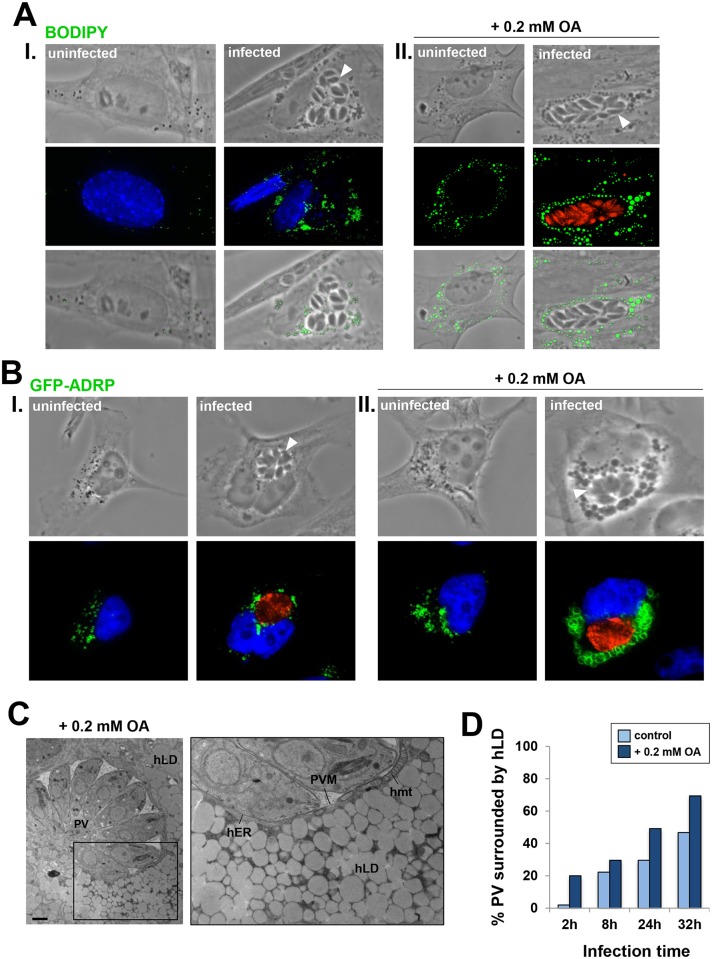
Influence of Toxoplasma infection on host LD distribution.A. Fluorescence microscopy of HFF infected with RFP-expressing Toxoplasma or WT for 24 h. Host LD were identified by staining with BODIPY 493/503 (green) and 4-,6-diamidino-2-phenylindole (DAPI, blue, nucleus). Uninfected and infected cells were incubated either under control conditions (corresponding to culture medium supplemented with 10% FBS that contains on average 3 μg/ml OA; in I) or with 0.2 mM OA added to the medium (corresponding to a ~20-fold excess of OA; in II). Images show host LD gathering around each PV, which was more pronounced upon OA addition. Arrowheads pinpoint PV. B. Fluorescence microscopy of GFP-ADRP-expressing HeLa cells infected with Toxoplasma for 24 h. The PV (arrowheads) were immunostained for GRA7 (red) in cells incubated with (in I) or without OA (in II). GFP-labeled host LD encircle the PV. In blue, DAPI. C. EM of HFF infected with Toxoplasma for 24 h and incubated with 0.2 mM OA during infection, confirming the amassing of host LD at the PV membrane (PVM). Host ER (hER) and mitochondria (hmt) remained associated with the vacuolar membrane (inset). Scale bar, 1 μm. D. Quantification of the percent of the PV population surrounded by host LD during infection, with or without exogenous 0.2 mM OA. GFP-ADRP-expressing HeLa cells were infected with Toxoplasma at the indicated times. PV were scored as LD-associated if > 70% of the total host LD population was grouped around the PV.